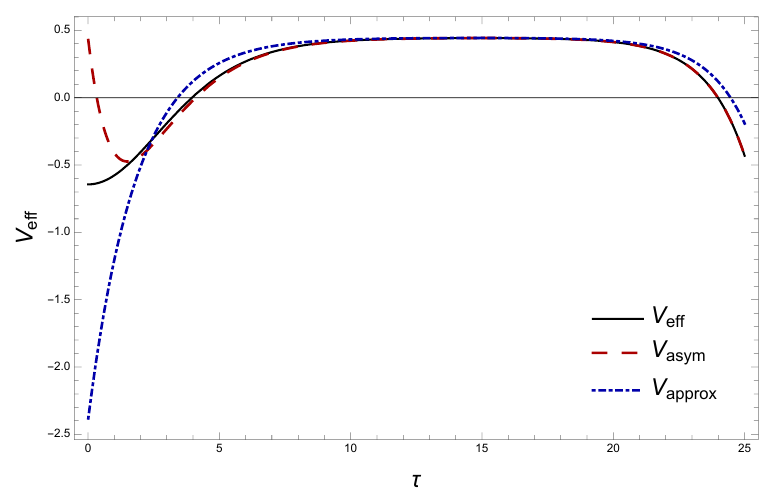
Figure 6 . Effective potential V eff (3.12) for the first excited mode, obtained numerically for τ c = 15 , T = 25 , together with V asym (3.28) and V approx (3.29) for the best fit values ( a, ν ) = (1 . 96 , 2 . 45)